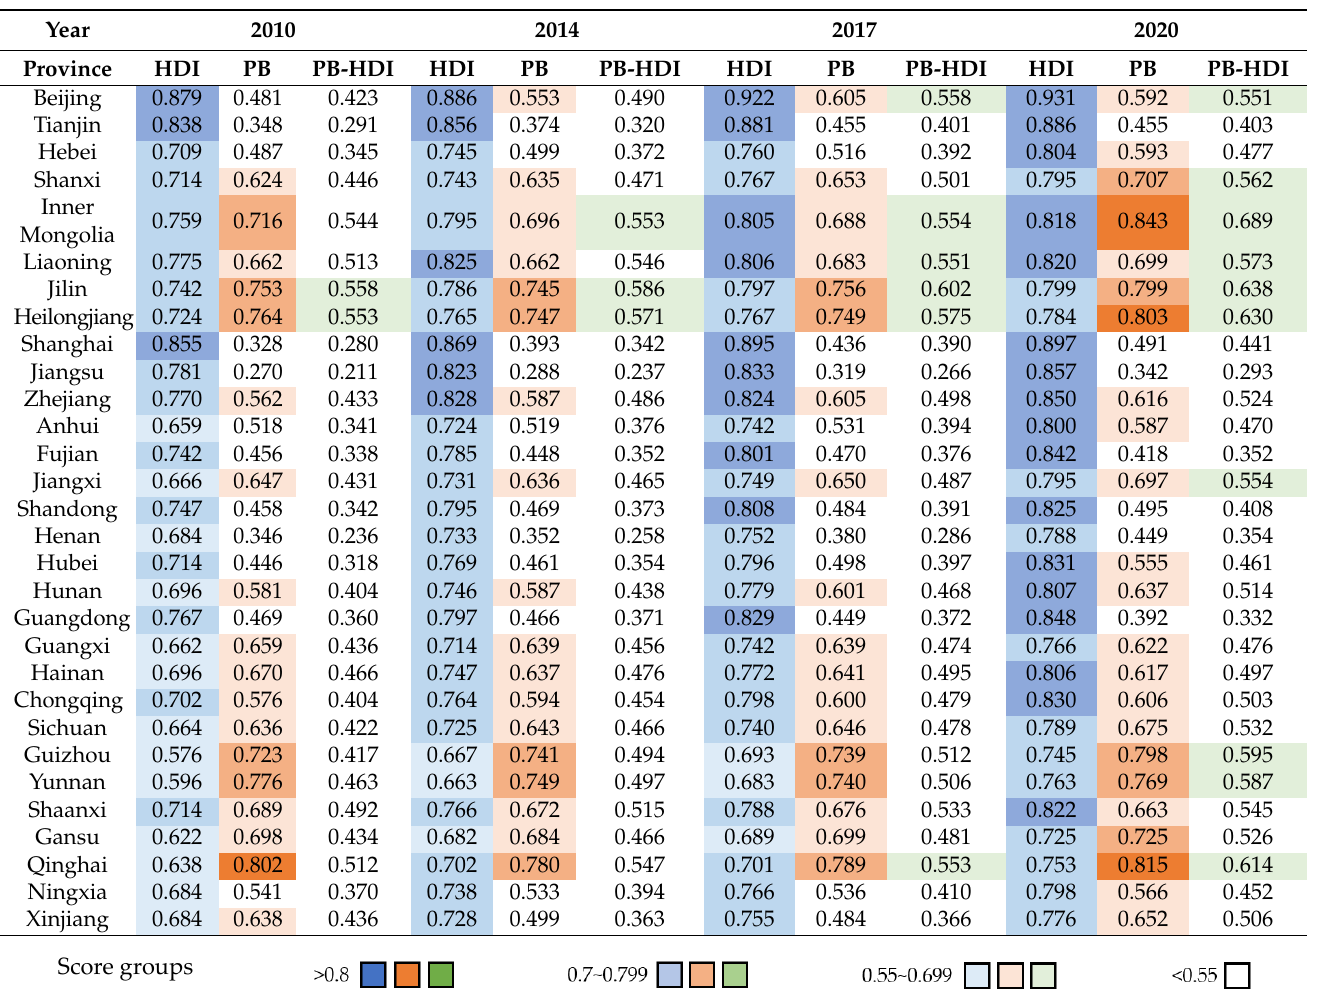
Table 3. PB, HDI, and PB-HDI indexes dashboards of various provinces over the years.